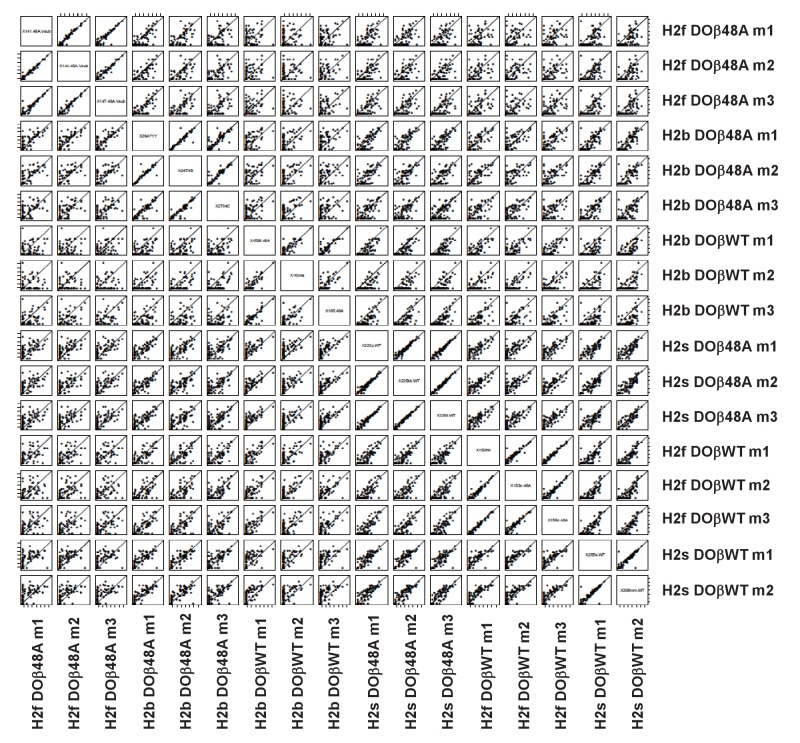
TRAV usage by naive CD4 T cells depends on the selecting MHCII allele and partner TCRβ.Pairwise scatter plots of individual TRAV frequencies between all replicates of mature naïve CD4 T cells from mice expressing different MHCII alleles and different TCRβ chains. Data are plotted as log2 transformed TRAV counts per 1 × 10^4 total TCRα sequences in each mouse noted on the x axis versus each mouse noted on the y axis. Values distributed along the diagonal are equivalent between the two mice compared in the plot. Individual mice of each genotype were numbered m1-m3, numbers for each mouse are used consistently throughout.